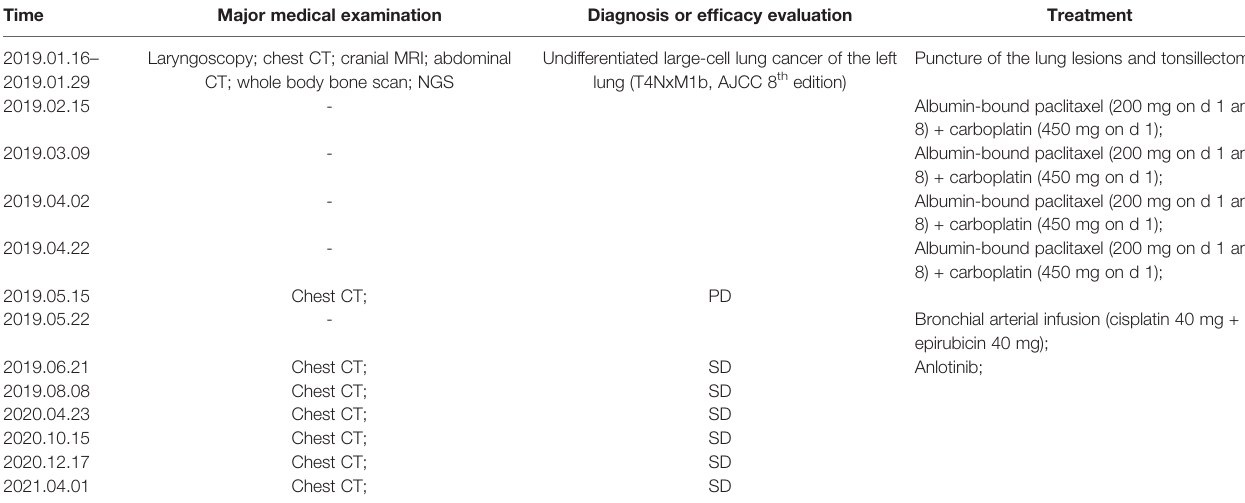
TABLE 2 | Timeline of the relevant